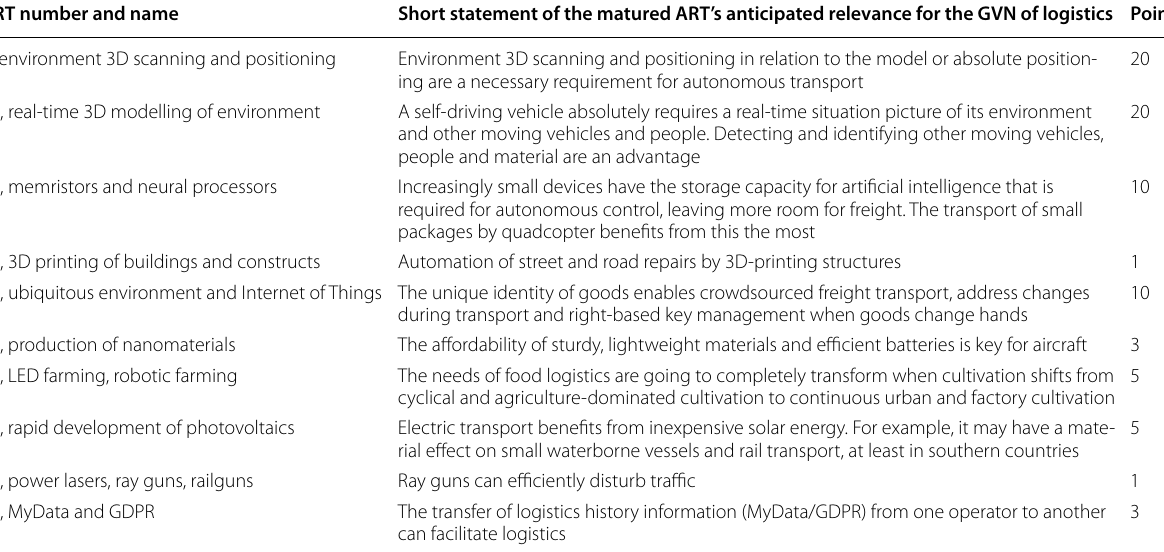
Table 3 Assessment of the relevance of ARTs for achieving the goal and values of the GVN of logistics, ten examples ART number and